Question: In a single sentence, describe what this figure presents.
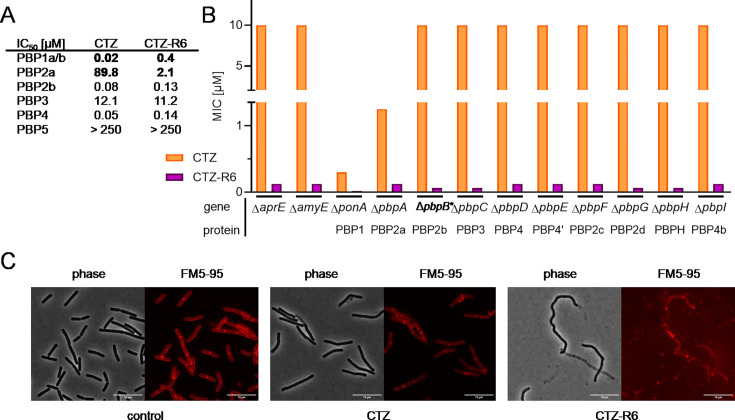
Answer: CTZ-R6 and CTZ target PBPs differently. ( A ) Binding profile to B. subtilis PBPs. IC50 values (calculated from the data published by Werner et al. [ 18 ]) represent the compound amounts required to competitively reduce binding of Bocillin FL by 50%. ( B ) MICs as mode values ( n = 3) for isogenic PBP-deficient B. subtilis knockout mutants and a xylose-inducible knockdown mutant of essential PBP2b (*). As the B. subtilis full genome knockout library does not contain an unmutated wild type, strains Δ amyE and Δ aprE from the same strain library were used as wild-type-like reference. Both genes are commonly used for insertions in genetic engineering, and their loss is without relevance for B. subtilis under most conditions. MIC values (µM) are presented as mode values. ( C ) Morphological aberrations induced by CTZ-R6, but not CTZ, in B. subtilis after 120 min at 1× MIC. Scale bar, 10 µm.